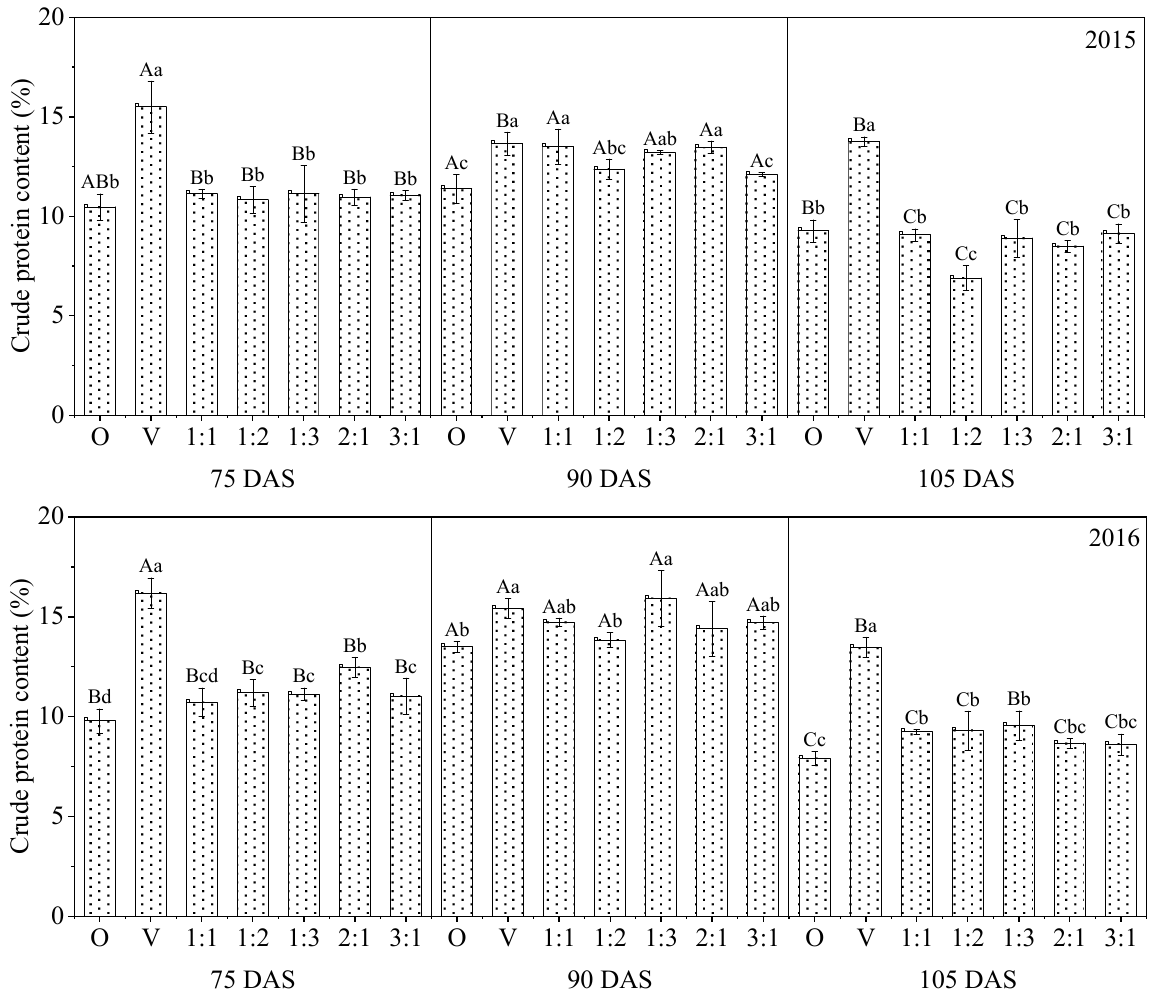
Figure 1. The effect of different intercropping ratio of oat and common vetch on crude protein content of forage. Note: Different capital letters indicate significant differences among different harvest days, and different lowercase letters indicate significant differences among different treatments ( p < 0.05), the same as below.